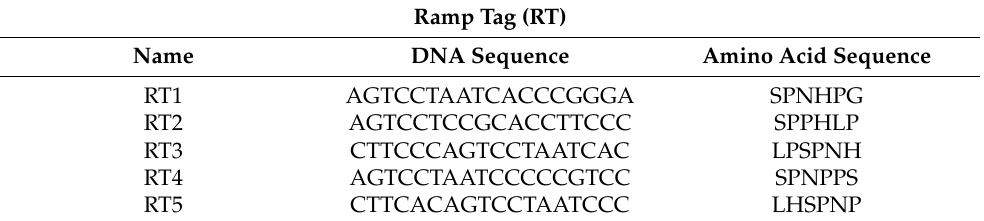
Figure 1. Schematic diagram of the DNA construct designed for the soluble expression of hy- drophobin DewA and protein expression behavior of a recombinant hydrophobin DewA with or without the signal sequence. ( A ) Design scheme of the DNA construct used for the soluble expression of recombinant hydrophobin DewA. The rationally designed ramp tag was N-terminally fused, and 6 × His tags were fused at the C-terminal region for Western blot analysis. The deleted signal sequence ( ∆ SS) of DewA is represented as a dotted box. ( B ) SDS-PAGE analyses (15 µ g of proteins) of soluble recombinant hydrophobin expression at two different culture temperatures. Protein expressions of three independent clones (#1–3) were induced with 0.2 mM isopropyl β -D-1-thiogalactopyranoside (IPTG) at 37 ◦ C (left panel) or at 18 ◦ C (right panel). M, protein marker; T, total fraction; S, soluble fraction; I, insoluble fraction. Black arrows indicate insoluble expression of hydrophobin RT5-DewA- 6xHis, whereas red arrows indicate soluble expression of hydrophobin RT5-DewA( ∆ SS 1-24 )-6xHis, wherein DewA( ∆ SS 1-24 ) represents that the entire predicted signal sequence (total 24 residues) was deleted. The molecular mass of RT5-DewA-6His and RT5-DewA( ∆ SS 1-24 )-6 × His are 15.7 and 13.4 kDa, respectively. Table 1. Designed ramp tags and their corresponding amino acid